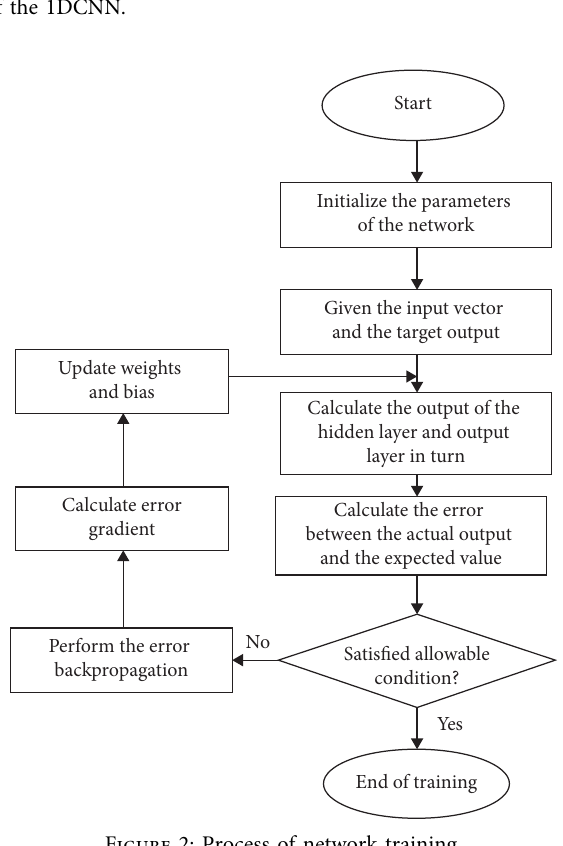
Figure 2: Process of network